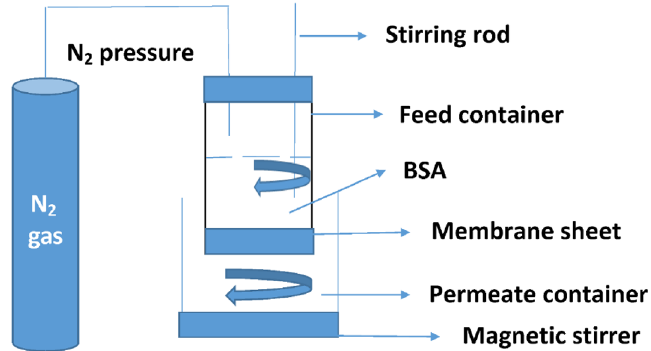
Figure 1. Schematic Figure of dead-end filtration cell for water flux and BSA rejection.